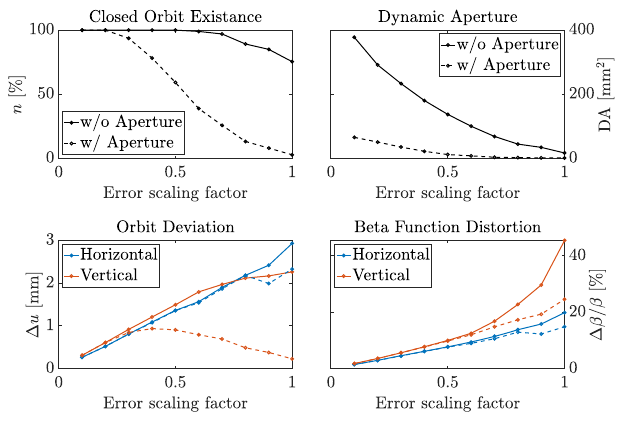
FIG. 9. Lattice properties without any correction for different scaling factors of the nominal error set. Plotted are the fraction of lattice realizations at which the closed orbit exists (upper left), the rms dynamic aperture (upper right), and the rms closed orbit deviation (lower left) and beta beat (lower right) each for the horizontal (blue) and vertical (red) plane. In all cases the values have been calculated with (dashed) and without (solid) the physical aperture